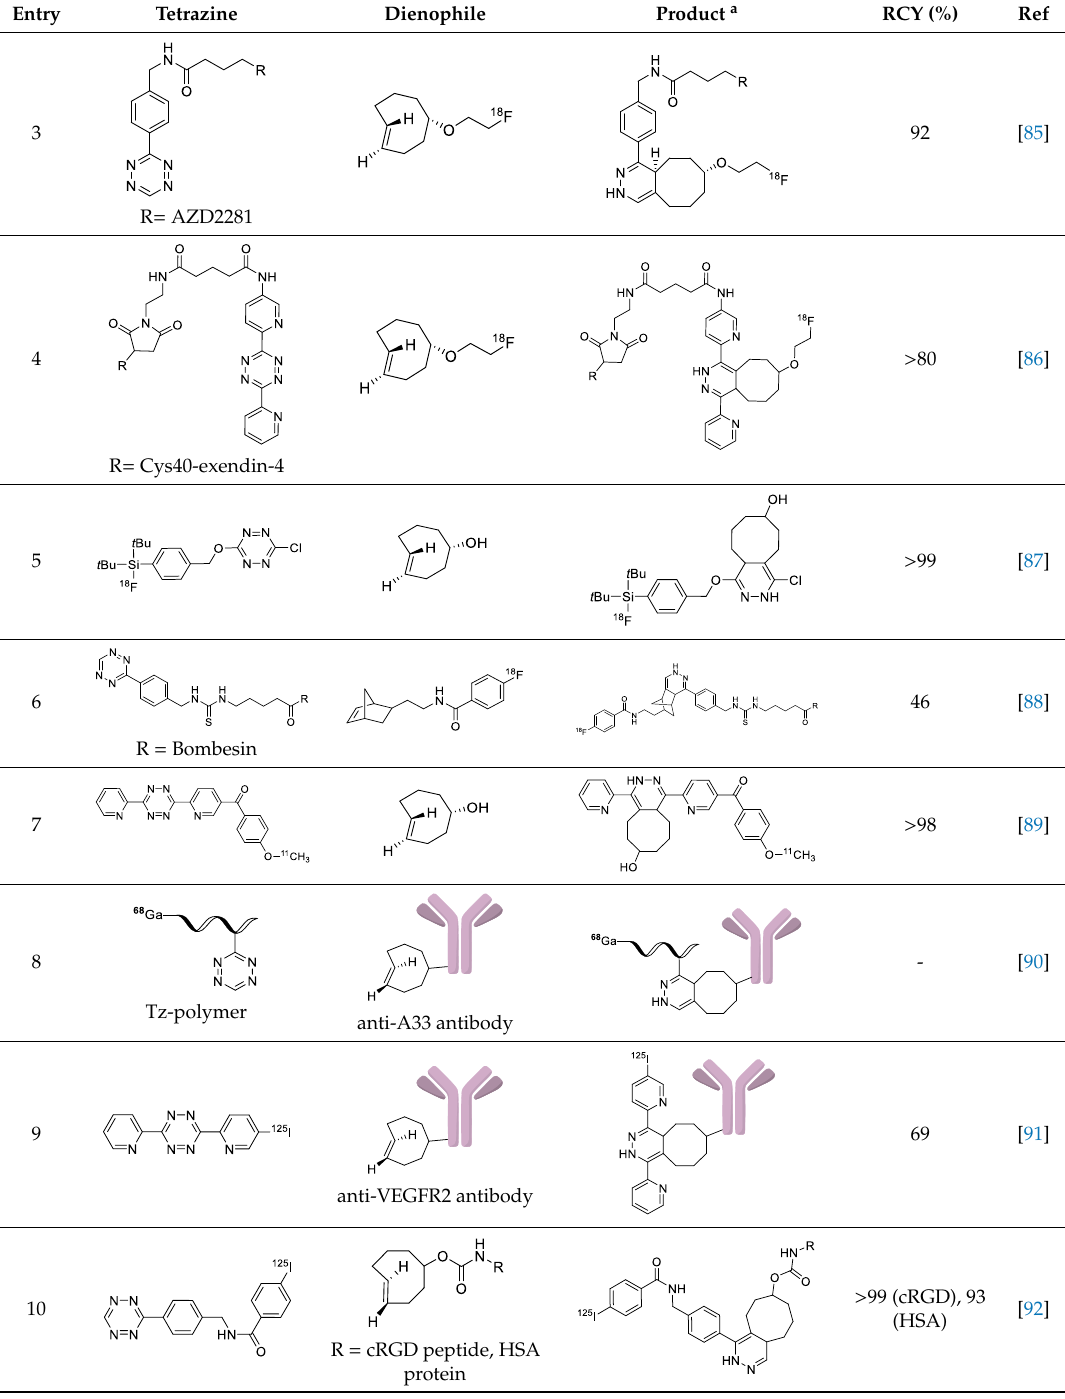
Figure 10. IEDDA-mediated radiolabeling of trastuzumab.